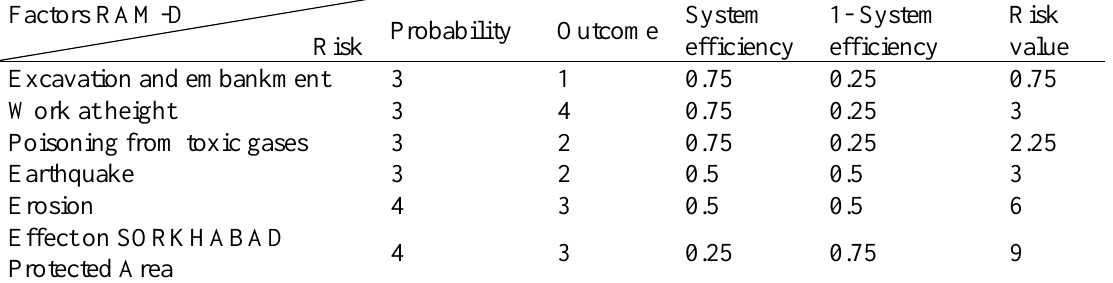
Table 9. Environmental risk assessment results of Paveh Rood Dam by RAM-D method Factors RAM-D System 1- System Risk Probability Outcome Risk efficiency efficiency value Excavation and embankment 3 1 0.75 0.25 0.75 Work at height 3 4 0.75 0.25 3 Poisoning from toxic gases 3 2 Earthquake Erosion Effect on SORKHABAD Protected